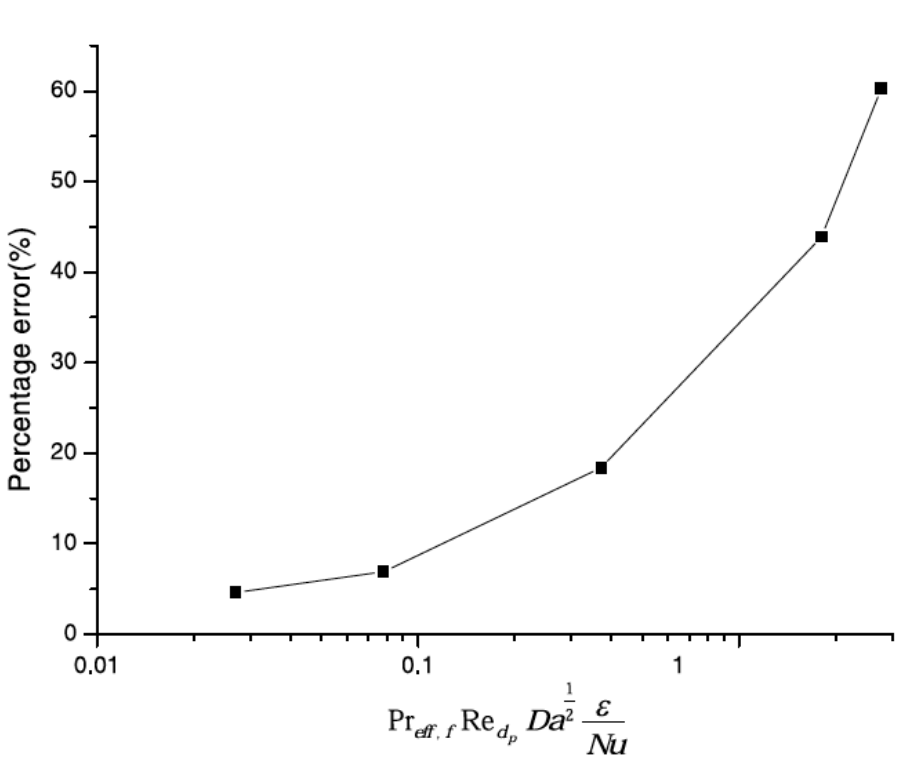
Figure 2. The percentage error (%) based on the criterion proposed by Kim and Jang [33] in Equation